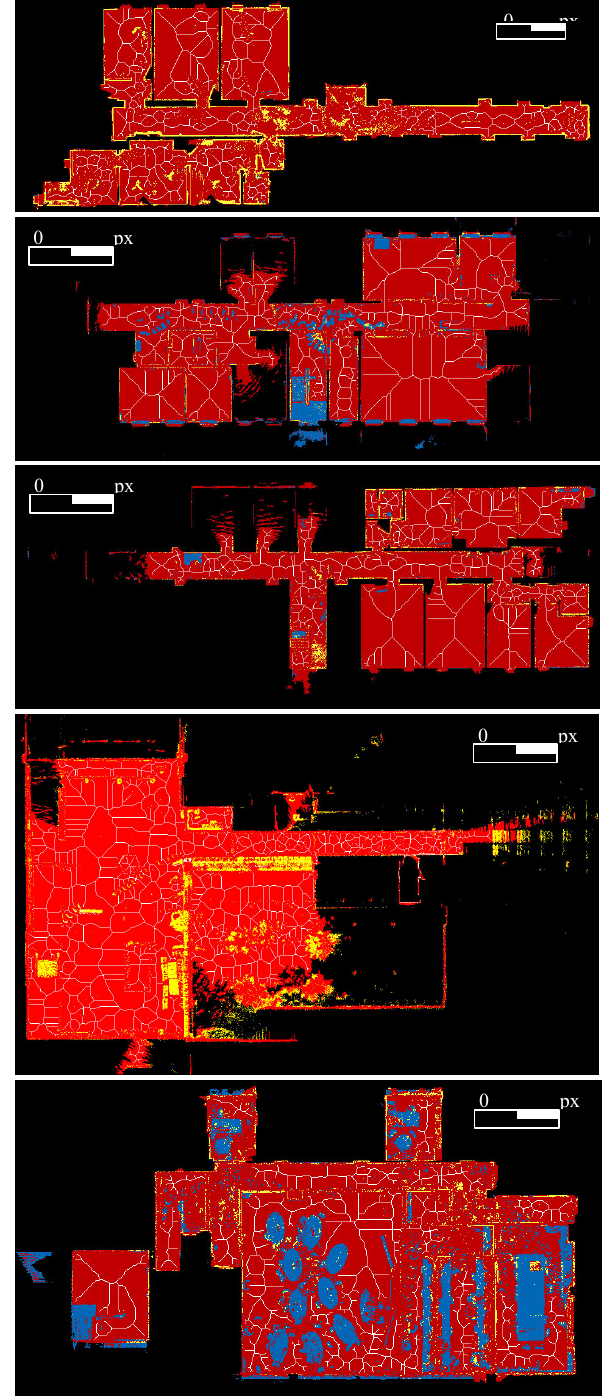
Figure 8. Object classification and walkable path estimation result (red regions: floors, yellow regions: walls, cyan regions: other objects, white lines: walkable paths) The processing environment was Intel Core i7-6567U (3.3